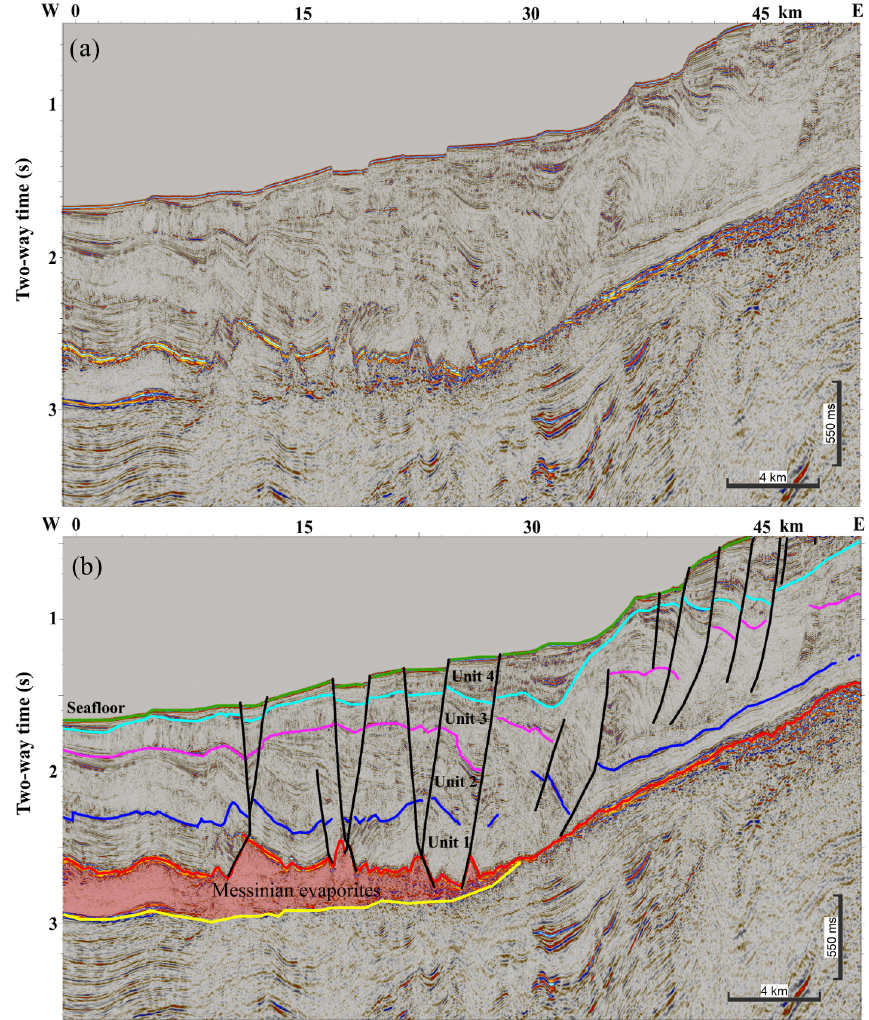
Figure 2. Uninterpreted (a) and interpreted (b) seismic section across the Levant continental margin offshore Israel (location in Fig. 1b). Chronostratigraphic and seismostratigraphic of the Pliocene–Quaternary section after Elfassi et al. (2019). Green – seafloor; light blue – base unit 4; purple – base unit 3; blue – base unit 2; red – base unit 1 (and top evaporites); yellow – base evaporates. Thin-skinned faults in black